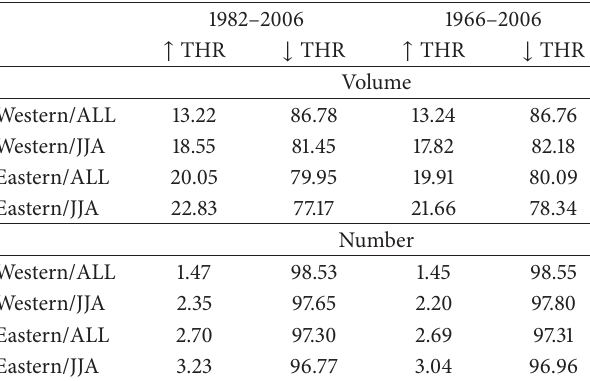
Table 3: Percentage of events above and below THR 1982–2006 and 1966–1981 for both regions and ALL and JJA